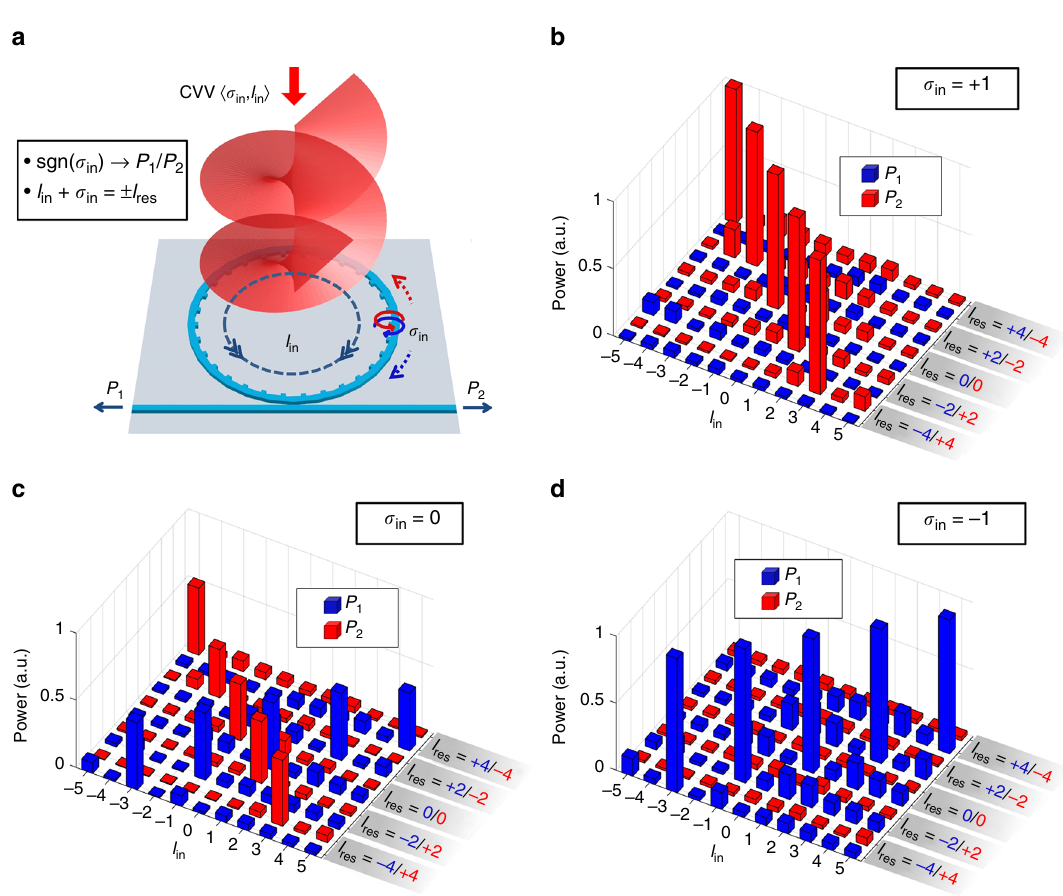
Fig. 7 Proof-of-principle demonstration of spin-orbit jointly controlled unidirectional coupling of waveguide modes. a Schematic of platform for receiving CVVs via spin-orbit unidirectional coupling effect. For devices of unity transverse-spin states in the evanescent region ( σ res = ±1), the propagation direction of coupled light in the waveguide, or the ratio of received power at the two ports P 1 / P 2 , is fi rst subject to the sign of incident SAM state, sgn( σ in ). Meanwhile, at a given wavelength ( λ res ), the incident spin-orbit states 〈 σ in , l in 〉 must obey the phase-matching condition l in + σ in = l res for high-ef fi ciency coupling. b – d Received power at Port 1 ( P 1 , blue bars) and Port 2 ( P 2 , red bars) of device WG 4 – 10 when the SAM state of incident wave σ in = + 1, 0, and − 1, respectively. For each σ in , CVVs at 5 resonance wavelengths of WG 4 – 10 (1578.61, 1583.11, 1587.59, 1592.11, and 1596.66 nm) and 11 OAM states ( l in = − 5, − 4, … , and + 5) are illuminated on the device. At these fi ve wavelengths, the CVVs emitted from the device would carry the topological charges of l ±2, 0, ∓ 2, ∓ 4, respectively, when injecting light into Port 1 (2), as marked in blue (red) on the l res axis in b – d . All measured power has been calibrated with respect to the lensed fi ber coupling loss (Supplementary Note 10), and all data are normalized to the highest value in each l res